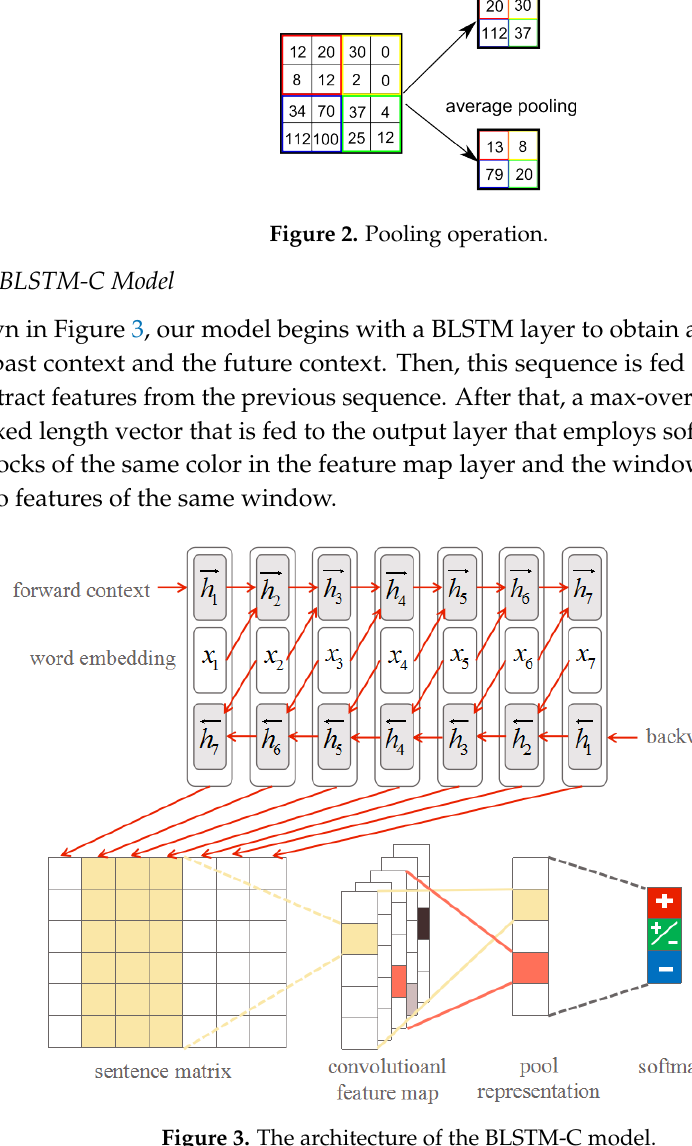
Figure 3. The architecture of the BLSTM-C